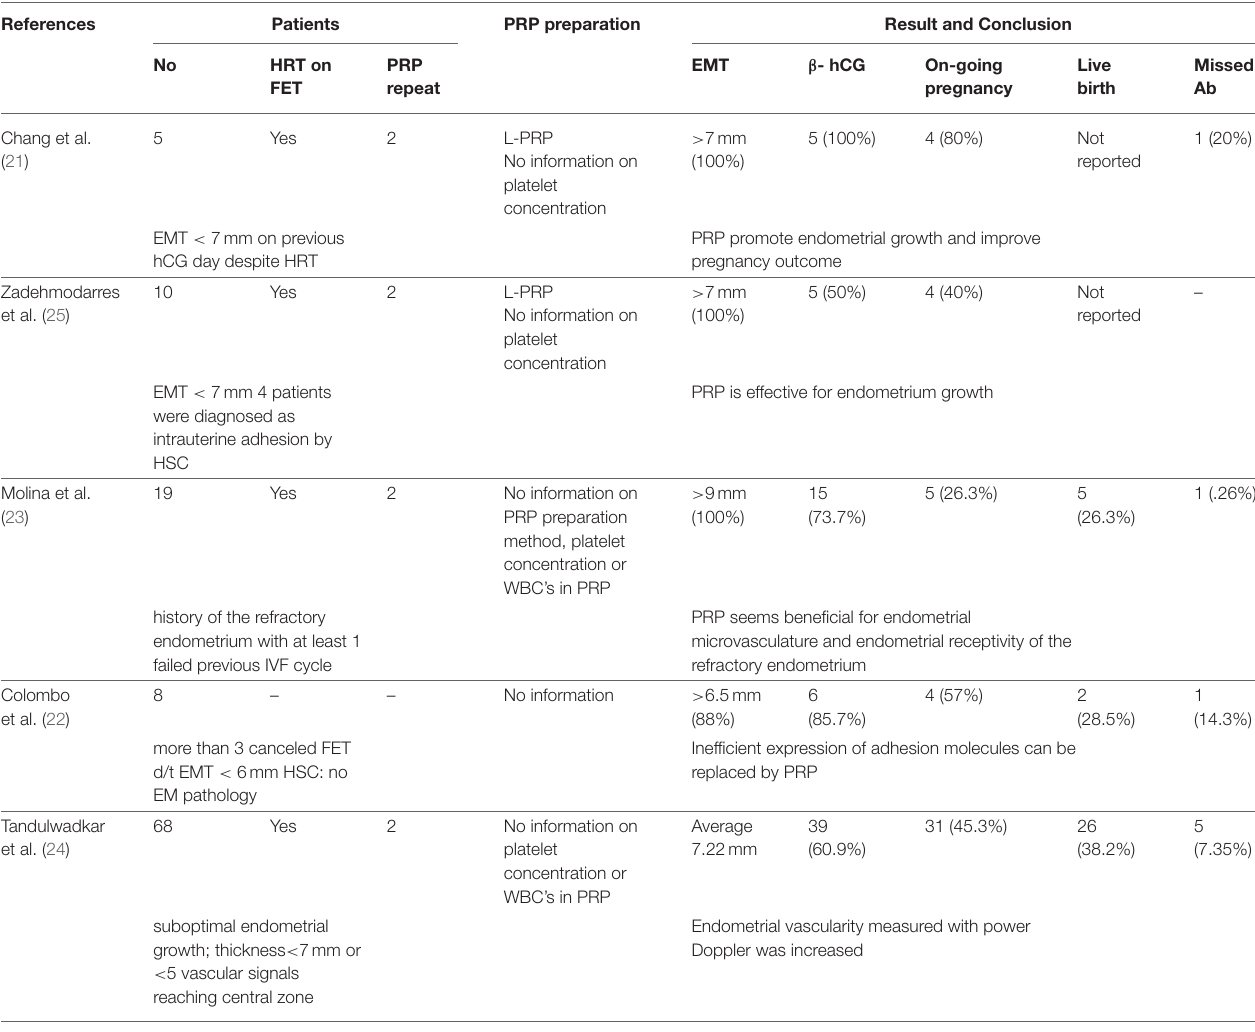
TABLE 4 | Previous studies on autologous PRP treatment of human